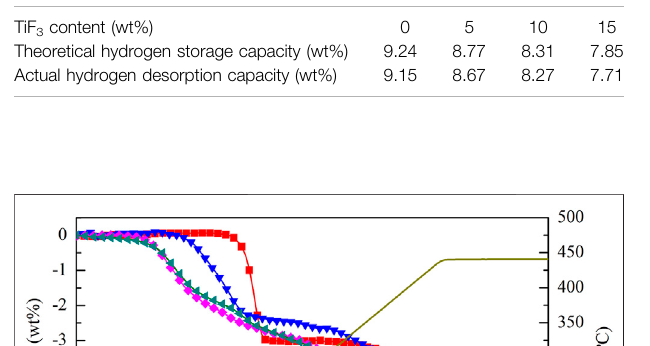
TABLE1| Theoreticalhydrogenstoragecapacityandactualhydrogendesorption capacity of 2LiBH 4 – Li 3 AlH 6 samples with different amounts of TiF 3